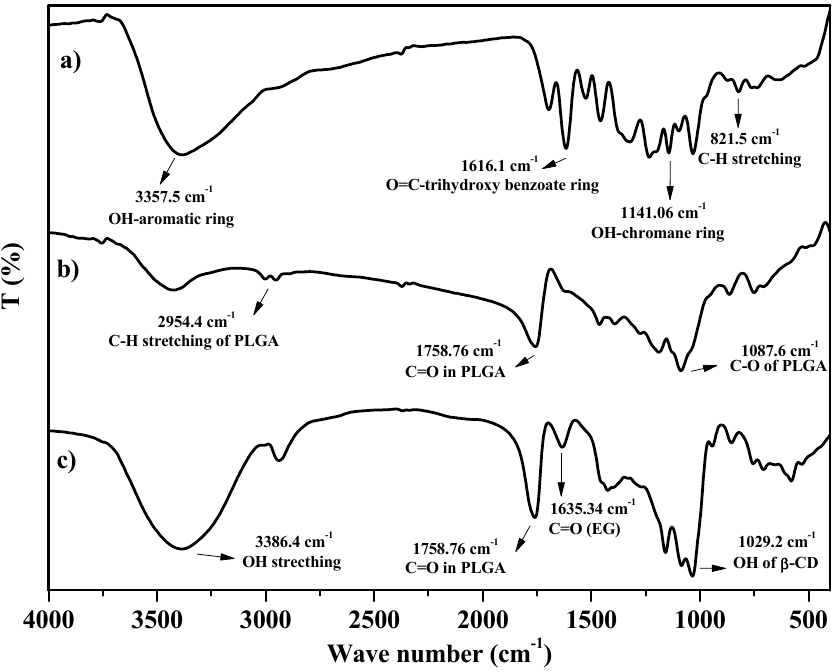
Figure 2. FTIR spectra of ( a ) EG; ( b ) PLGA-EG; and ( c ) PLGA-CD-EG.